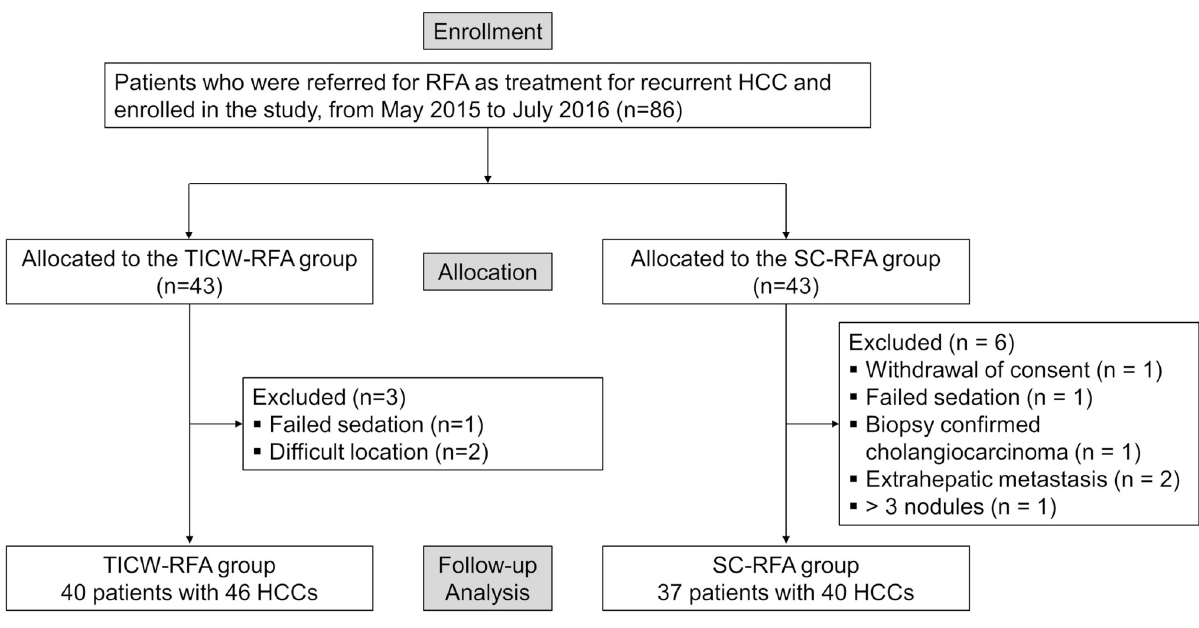
Fig 1. Flow chart of the study